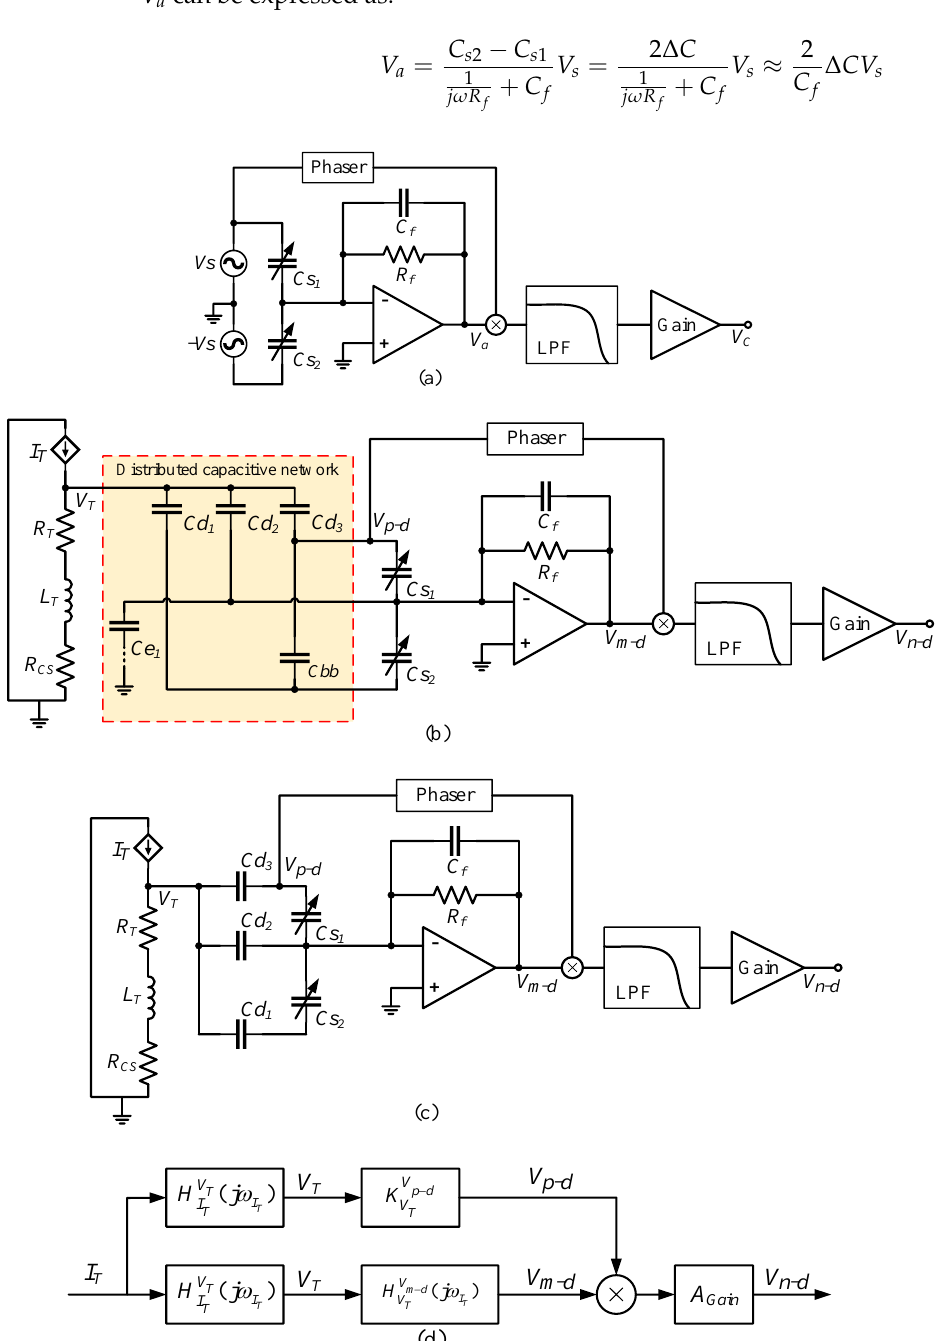
Figure 5. DCM detection circuit and its detection noise transfer path. ( a ) DCM detection circuit; ( b ) Detection noise transfer path composed of DCM detection circuit; ( c ) Simplified path of detection noise transfer formed by DCM detection circuit; ( d ) Structure of detection noise transfer system in DCM detection circuit.